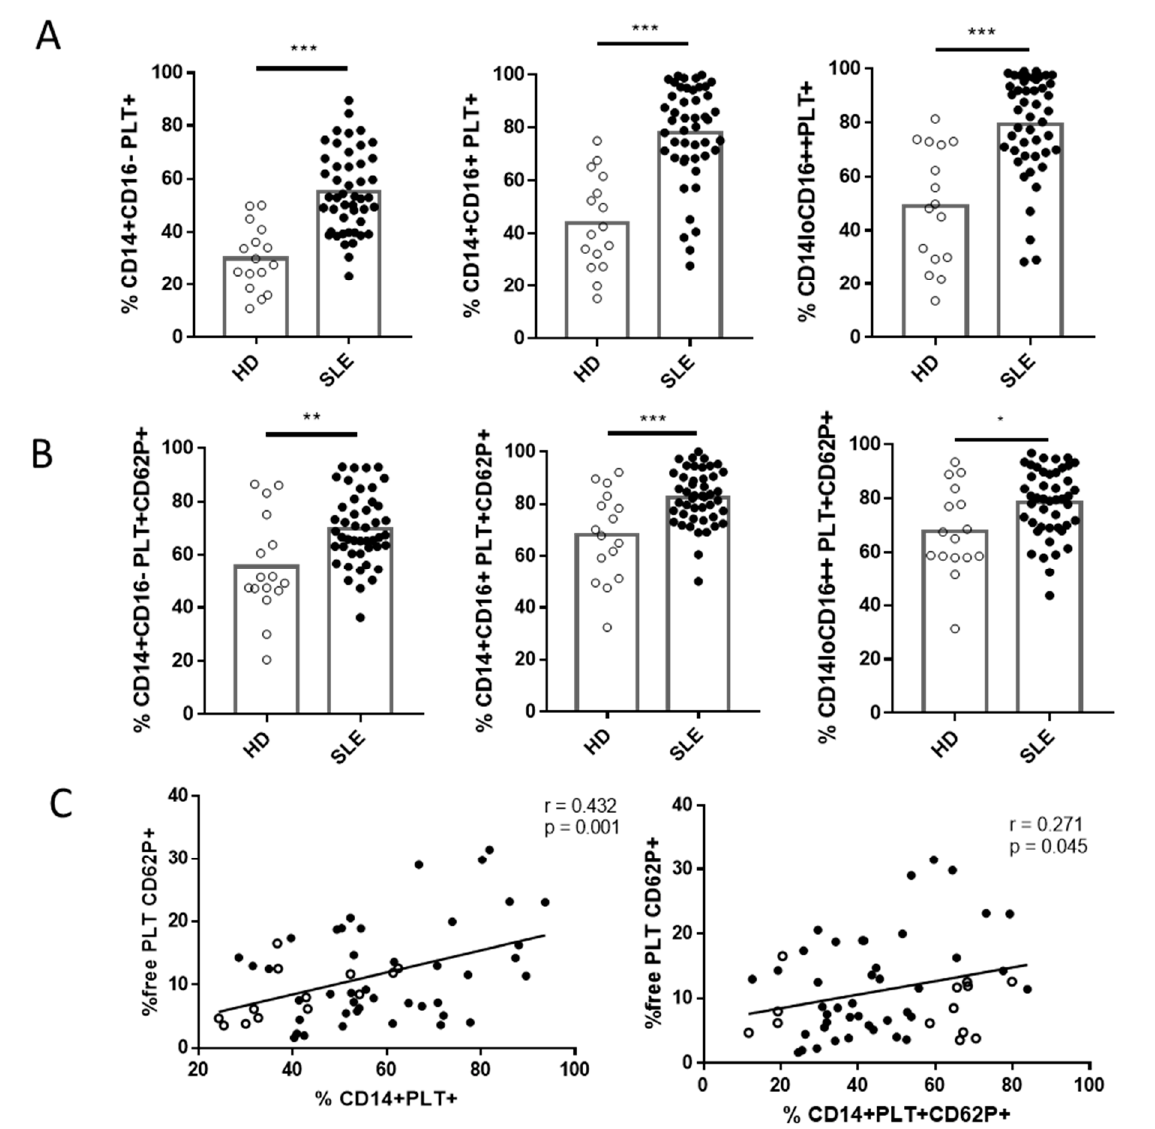
Figure 4. Monocytes with bound platelets and their relationship with free platelets in HD and SLE patients. ( A ) Percentage of monocyte subsets with bound platelets (PLT+) in HD and SLE patients. ( B ) Percentage of monocyte subsets with activated bound platelets (PLT+CD62P+) in HD and SLE patients. ( C ) Correlation between the percentage of CD14+PLT+ and CD14+PLT+CD62P+ with the percentage of free activated platelets (free PLT CD62P+) in HD and SLE patients. White circles represent HD ( n = 16), and black circles represent SLE patients ( n = 49). Statistical analysis was performed using the unpaired t -test (CD14+PLT+, CD14+PLT+CD62P+) for comparisons between HD and SLE and Spearman’s correlation for correlation analysis. * p < 0.05, ** p < 0.01, and *** p <0.001.